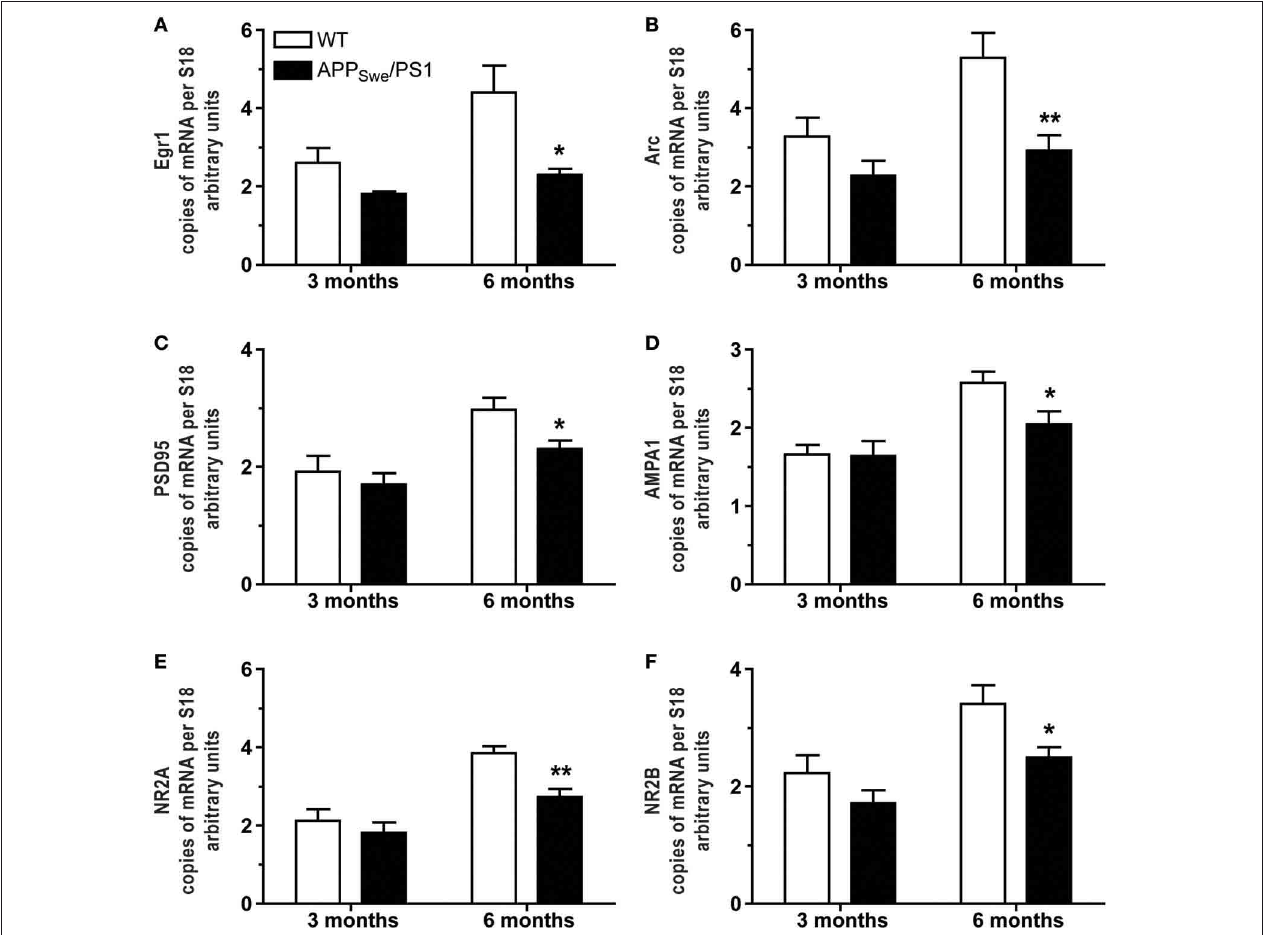
FIGURE 4 | Occurrence of mnesic deficits correlate with decreased mRNA levels of synaptic markers in hippocampus of APP Swe /PS1 mice. Real-time qPCR was used to quantify Egr1, Arc, PSD95, AMPA1, NR2A, and NR2B mRNA levels in the hippocampus. The values were normalized relative to the level of S18 mRNA detected in each sample. 3-month-old WT and